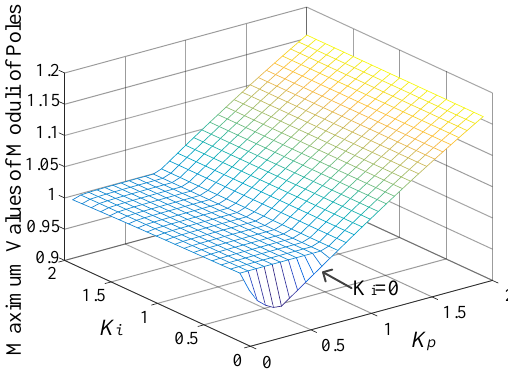
Figure 13. Maximum values of moduli of poles of T(z) with different GPI2(z) controller parameters.